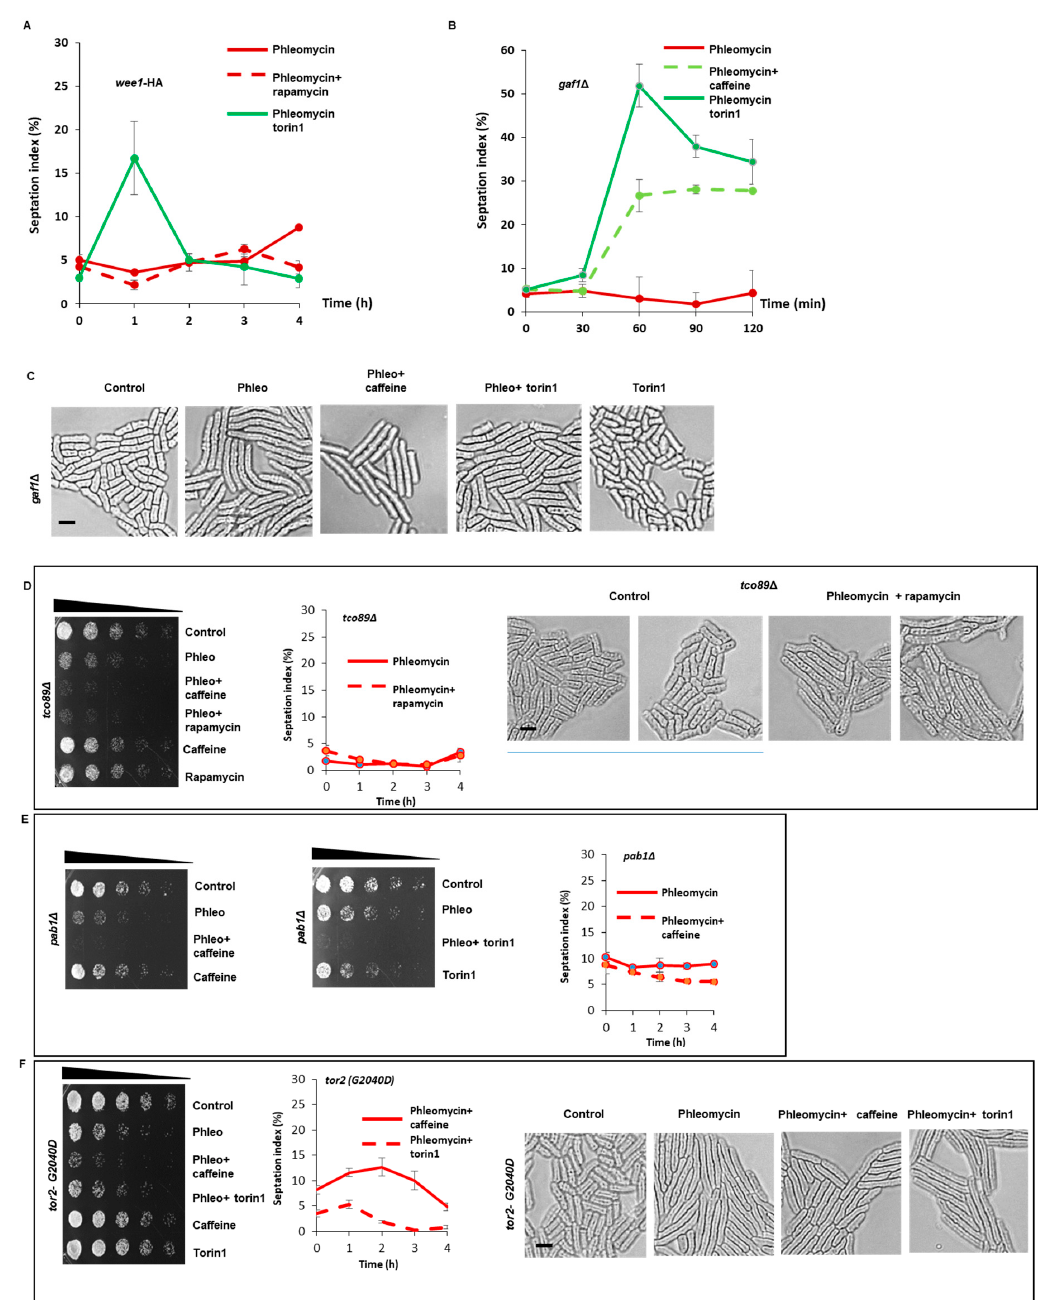
Figure 6. TORC1 inhibition by caffeine overrides checkpoint signalling similarly to caffeine. ( A ). Wt cells were incubated with 5 µg/mL of phleomycin for 2 h. The cultures were then incubated for a further 2 h in the presence of 200 ng/mL rapamycin or 5 µM torin1. Samples were harvested at the indicated time points. Cells were fixed in 70% ethanol, stained with calcofluor white and the septation index determined by fluorescent microscopy. ( B ). gaf1 ∆ mutants were incubated with 5 µ g / mL of phleomycin for 2 h. The cultures were then incubated for a further 2 h in the presence of 10 mM ca ff eine or 5 µ M torin1. Cells were fixed in 70% ethanol, stained with aniline blue or calcofluor white and the